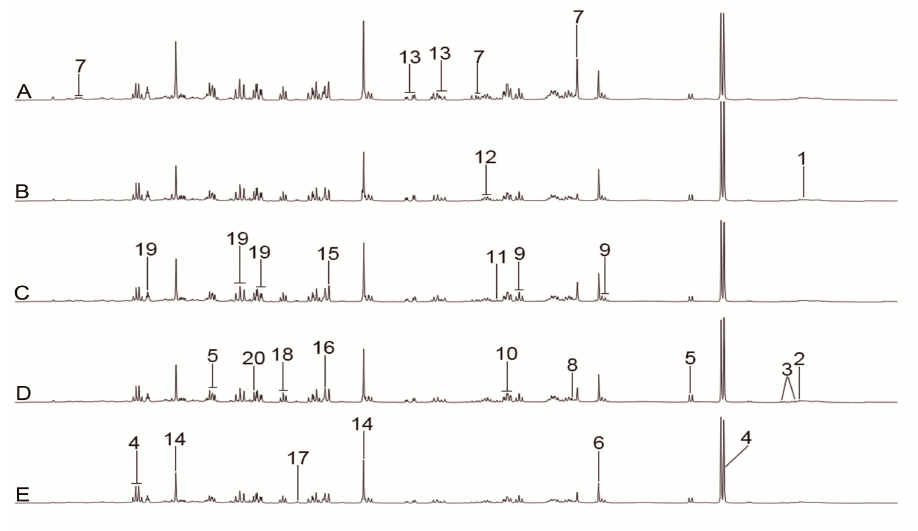
Figure 5. Representative 1 H-NMR spectra (0.5–4.7 ppm) of brain tissue for the control ( A ), model ( B ), nimodipine ( C ), H-TCNDS ( D ), and L-TCNDS ( E ) groups. Key metabolites: 1. isoleucine; 2. leucine; 3. valine; 4. lactate; 5. alanine; 6. acetate; 7. N -acetyl-aspartate; 8. N -acetylaspartylglutamate;